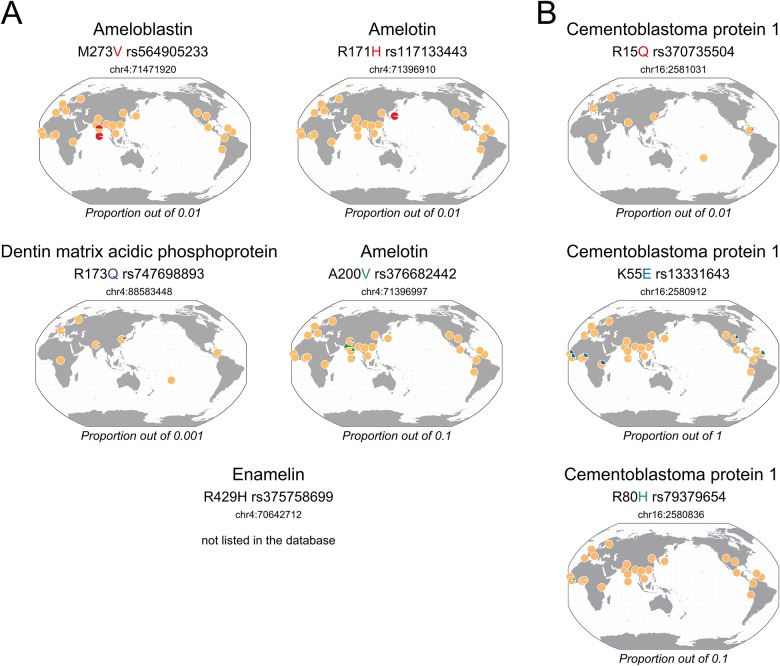
Geographical distribution of dental protein variants A: specific to Denisova, B: at least present in Denisova in living people.The colored amino acid correspond to the archaic variant. Yellow corresponds to the major allele, blue, green, red and purple corresponds to minor alleles with a proportion out of 1, 0.1, 0.01 and 0.001, respectively. The maps were generated in the Geography of Genetic Variants Browser (http://popgen.uchicago.edu/ggv/) [50].